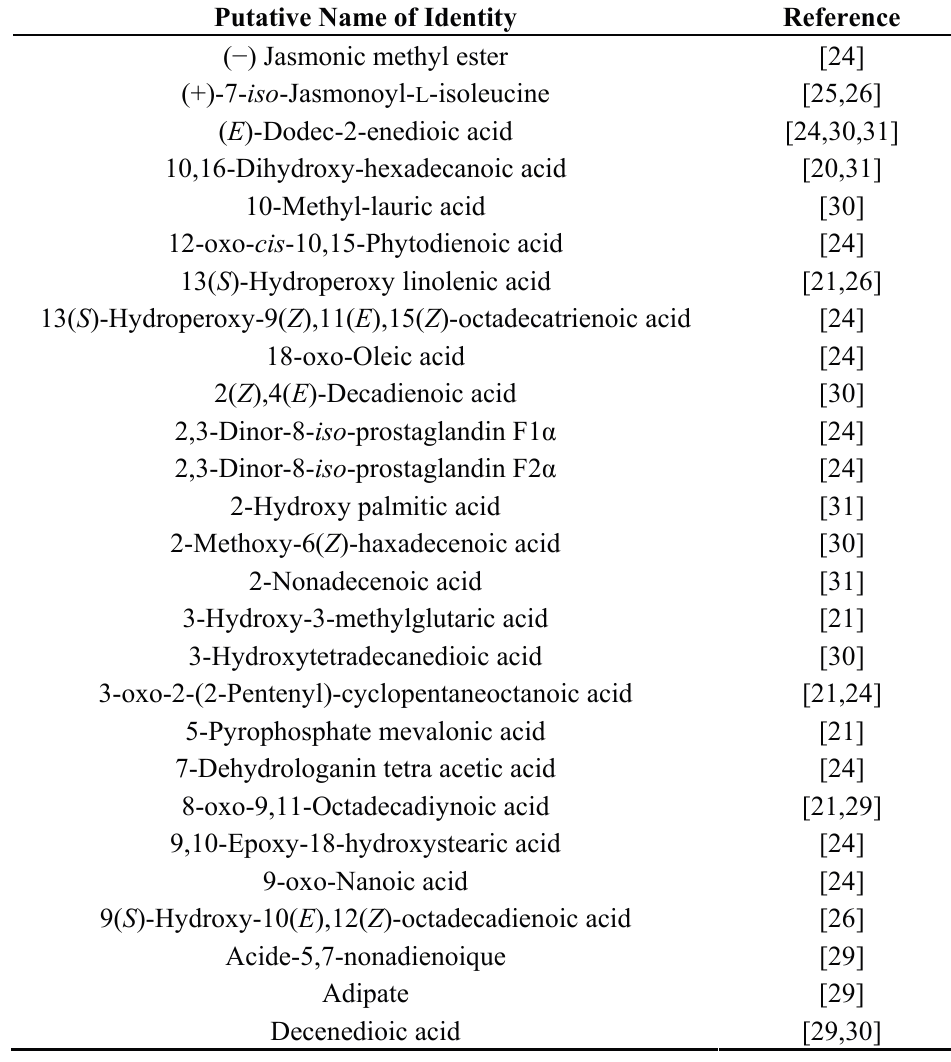
Table 4. Metabolites pinpointed for their potential contribution to FHB resistance and classified as fatty acids and